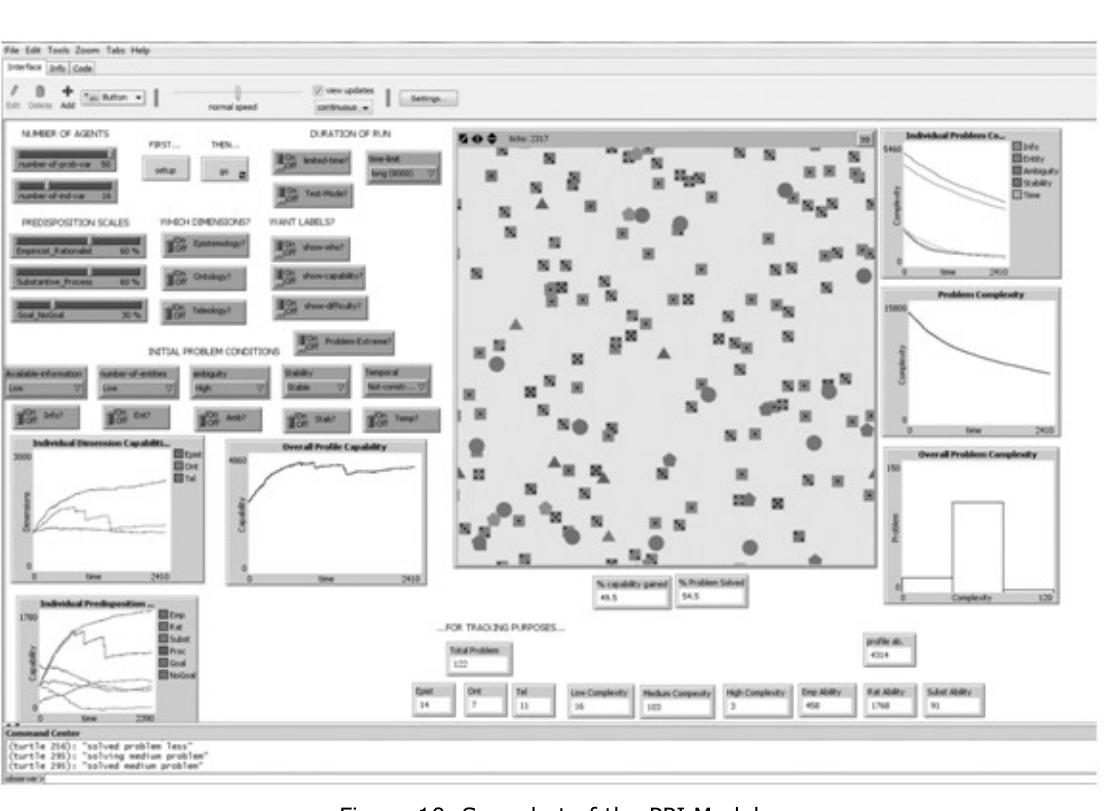
Figure 10. Snapshot of the PPI